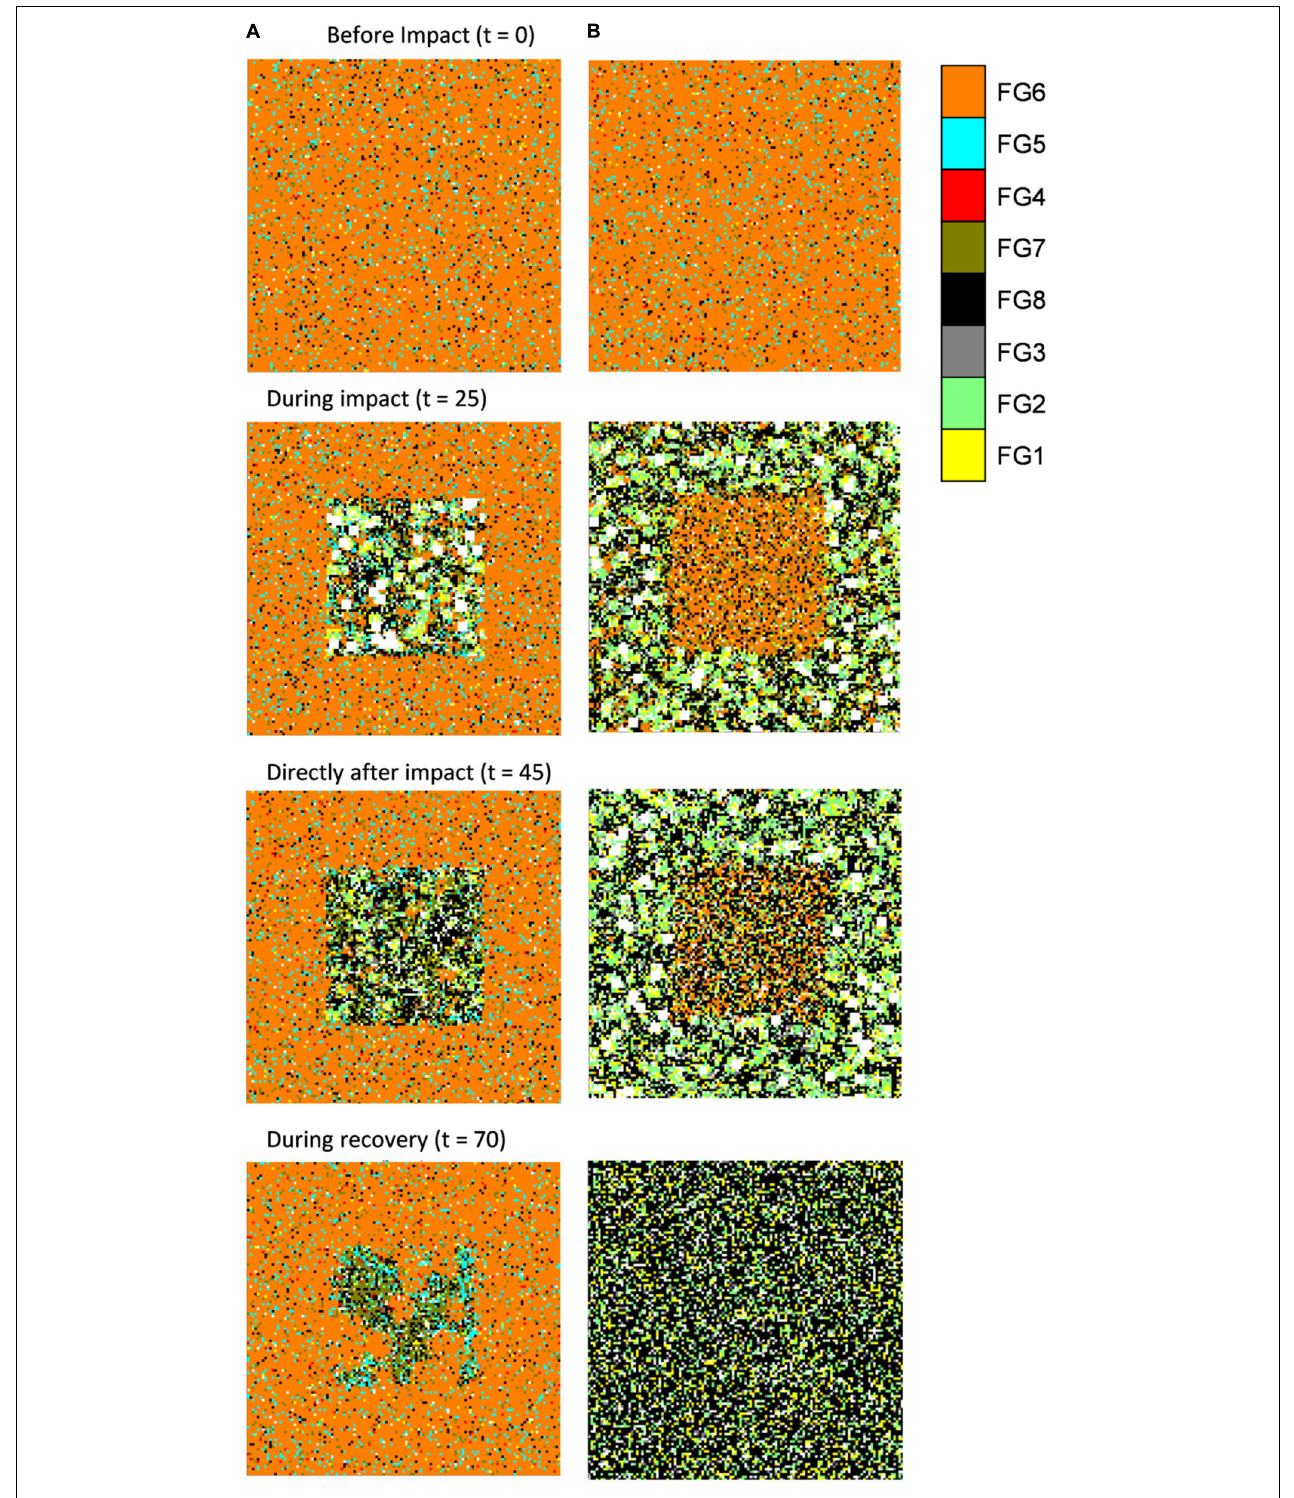
FIGURE 6 | Visual output of the disturbance recovery model parameterized with (A) 20% disturbance per year for 35 years within an impact area equaling 25% of the total model area (75% of the area is protected); (B) 20% disturbance per year for 35 years within an impact area equaling 75% of the total model area (25% of the area is protected). Timesteps presented are: Before impact ( t = 0); During impact ( t = 25); Directly after impact ( t = 45); During recovery ( t = 70). FGs were assigned colors by a subjectively defined hierarchical order of importance (order shown in legend), e.g., if FG 6 was present then cell was colored orange, if FG 6 was not present but FG 5 was present this was colored blue, and so on. If no FGs were present (as is the case directly after disturbance) the cell was colored white.